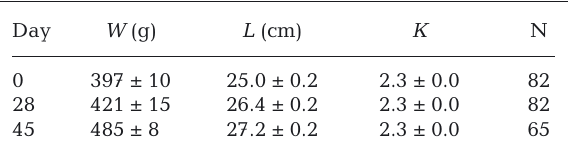
Table 1. Overall mean (± SE) gilthead sea bream Sparus aurata weights ( W , g), lengths ( L , cm fork length), condition factor ( K , calculated as 100 W / L 3 ) and total number of fish (N) in the 3 replicate tanks at the start of the experiment (Day 0), on Day 28 and on Day 45. Two fish from 1 of the replicate tanks were taken out on Day 28 due to their low weights (approximately 100 g), and 5 fish from each tank were taken during blood sampling on Day